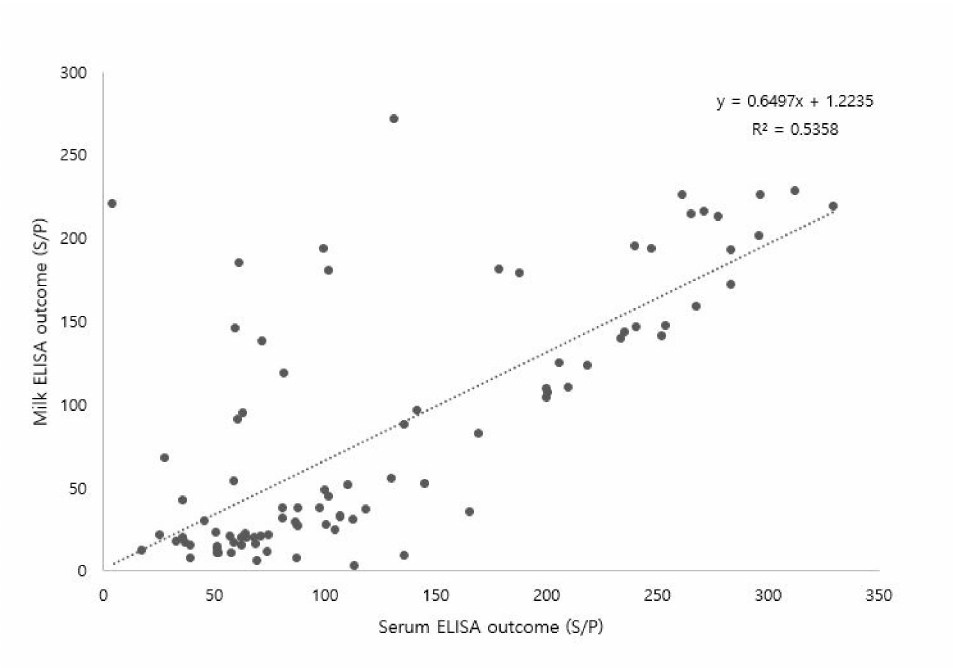
Figure 2. The correlation between the outcomes of serum and milk ELISA results (180 measurements; 7cows; R 2 = 0.5358; p ≤ 0.00). Thecut-o ff valueusedforthemilksamplesdependsonasample-to-positive (S / P) ratio ≥ 30 while that of the serum samples was S / P ≥ 55. Each dot indicates one milk and serum ELISA outcome (cows were measured repeatedly).